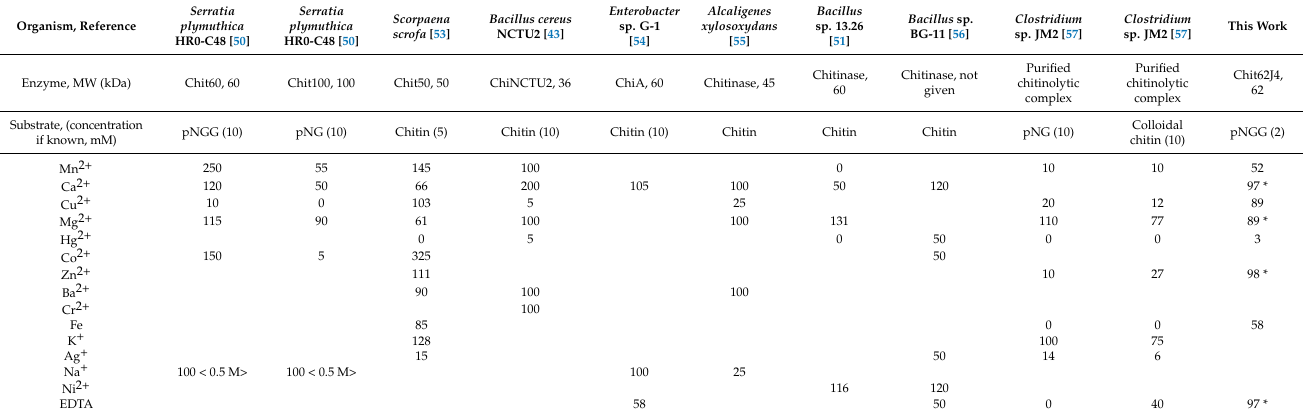
Table 4. Inhibition and stimulation effects in selected chitinases. Inhibitor concentration was 5 mM unless a different value is given in brackets. Percentage of original activity is given. Values marked with * are the mean values for substrate concentration 3.5 mM from kinetics in this work.